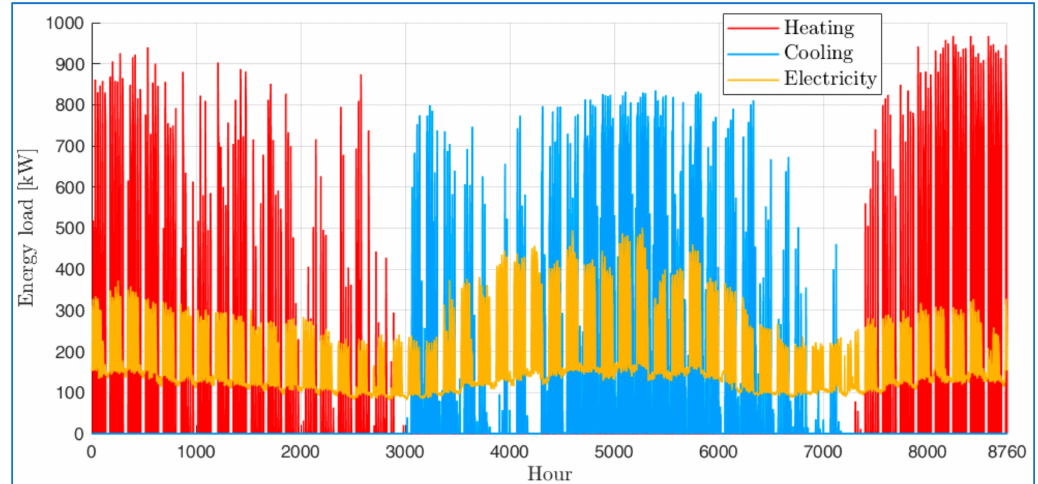
Figure 5. Hourly energy demand data of the case study.